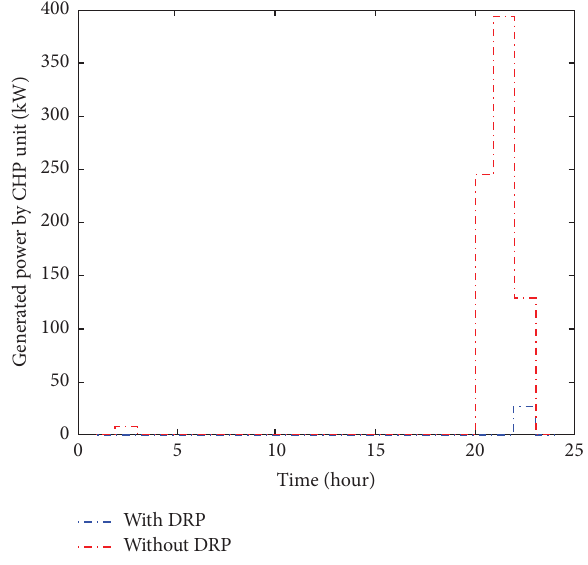
Figure 11: Generated power by CHP